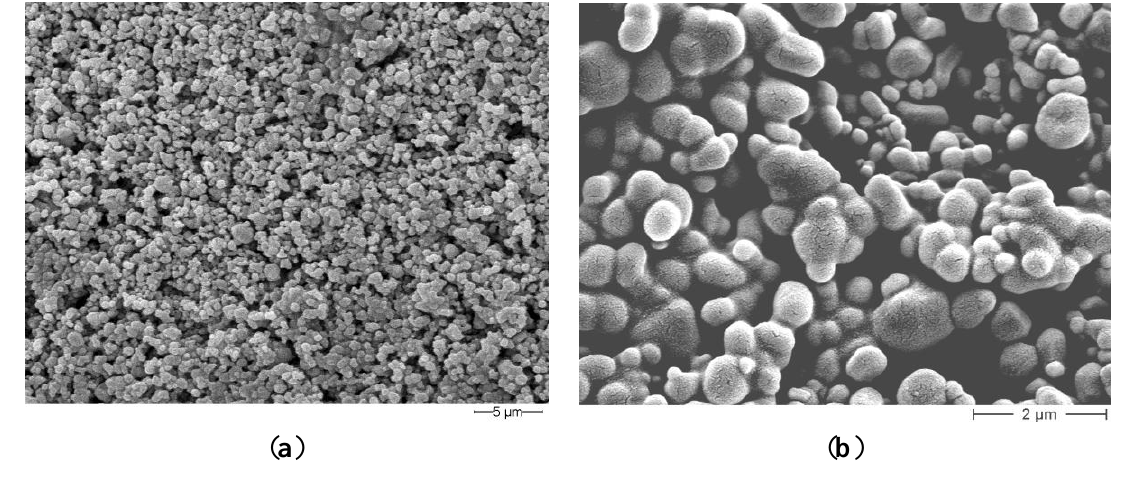
Figure 8. ( a ) SEM micrograph of Sr-doped hematite (×3,000); ( b ) FESEM micrograph of Sr-doped hematite